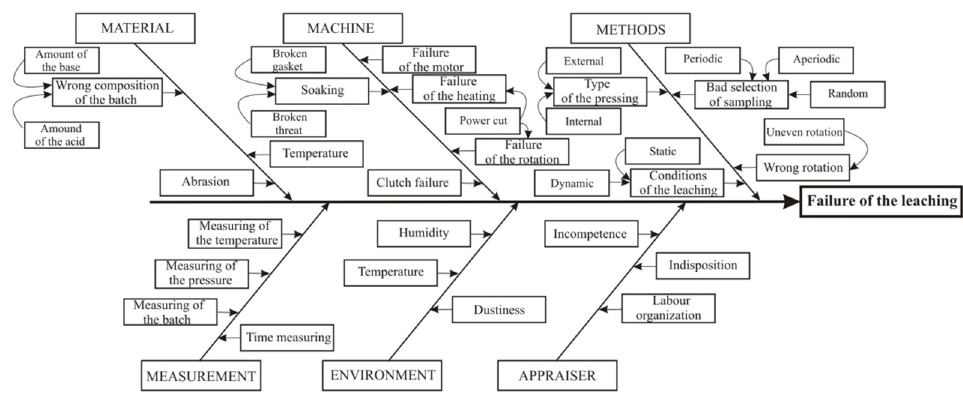
Figure 1. Ishikawa Figure 1. Ishikawa diagram.